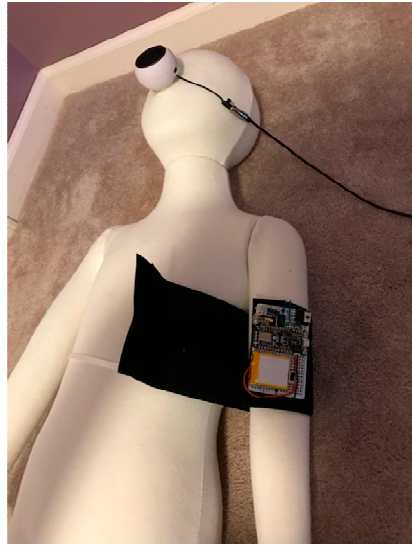
Figure 12. Wearable gadget attached at the upper left arm of a mannequin.